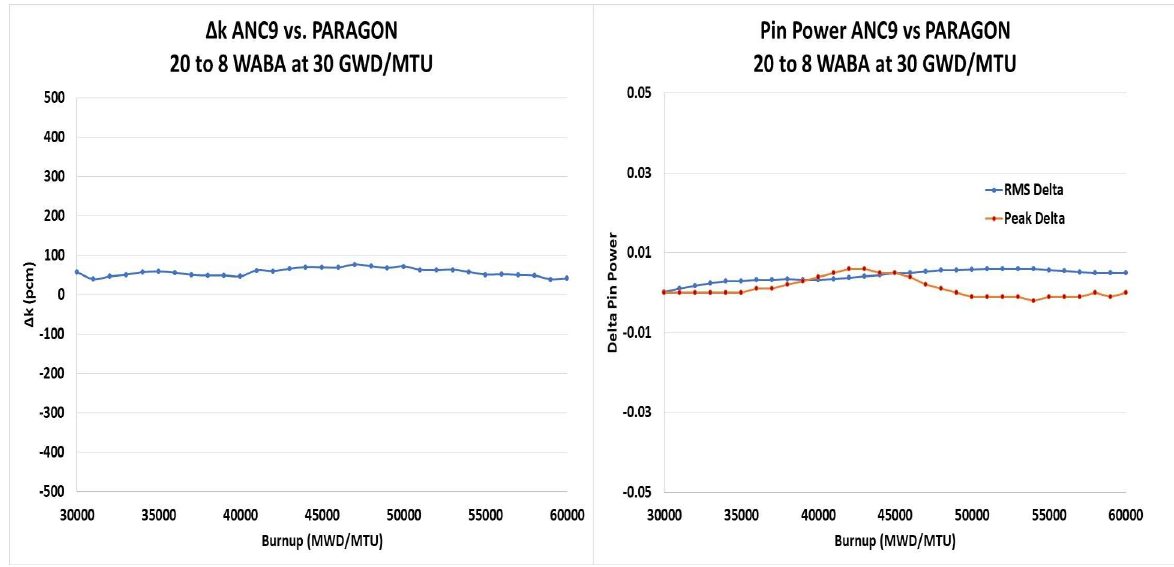
Figure 8. Comparison of eigenvalue and pin power for WABA replacement from 20 to 8 rods at 30